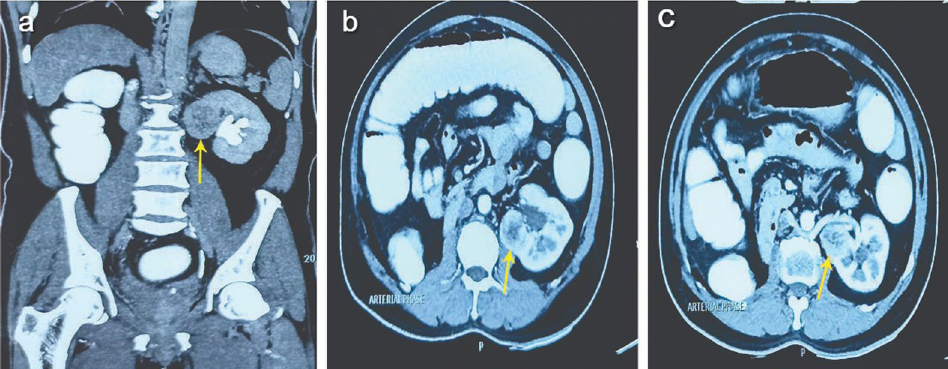
Fig. 1 a , b and c Computed tomography showing left renal complex hilar tumor (marked with yellow arrow)